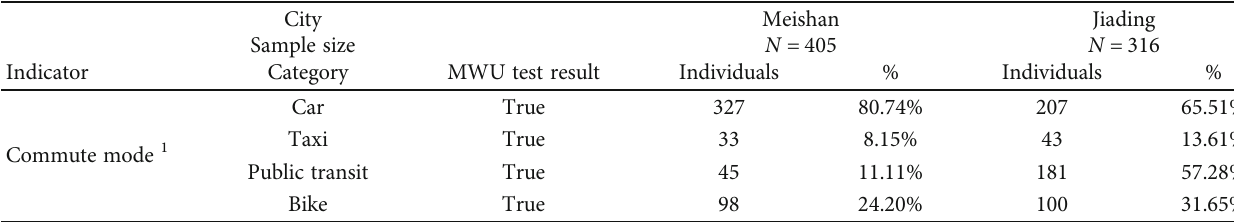
Table 1: Commuting mode characteristic of the sample in the two cities.